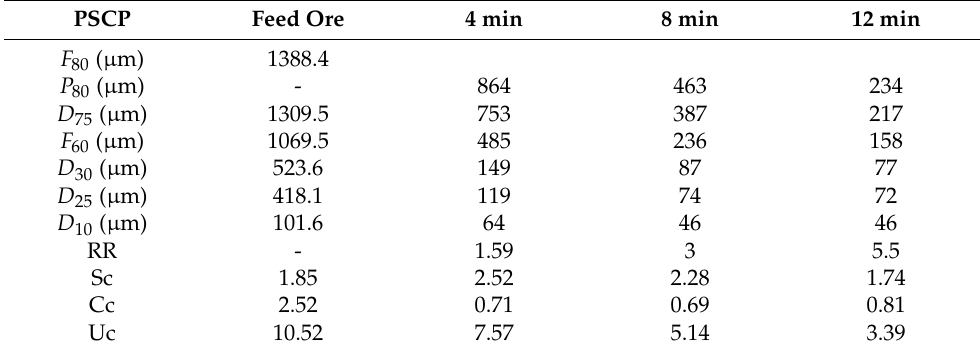
Table 1. PSCP of the feed and under different grinding